Question: Author a descriptive caption for the visualization shown.
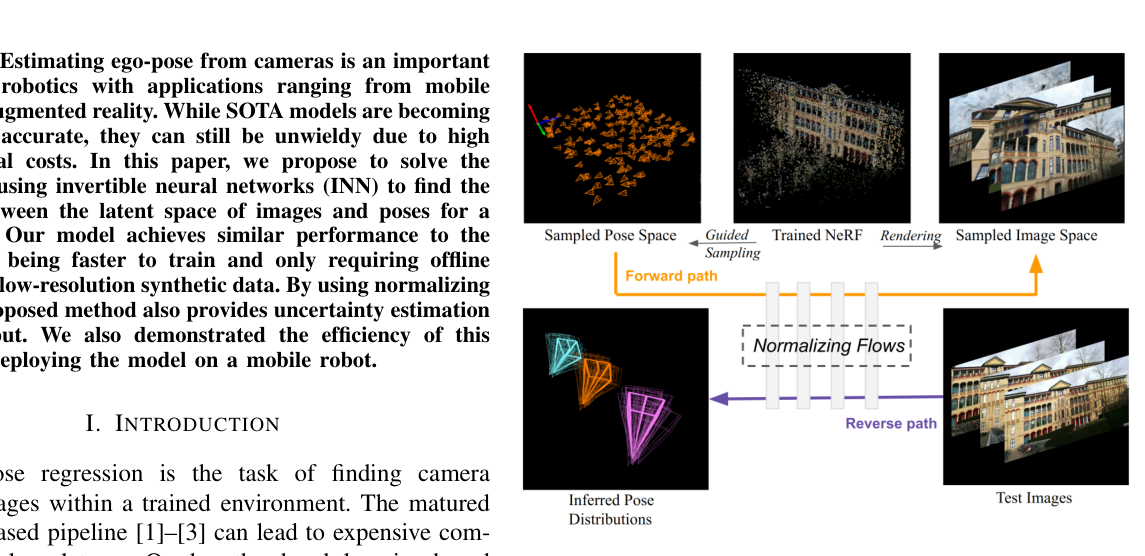
Answer: We propose to learn a mapping between the latent space of the images and camera poses in an environment with an invertible neural network. We use NeRF to guide camera pose sampling and render synthetic images. Evaluating the reverse path of the INN outputs the full posterior distribution of camera poses given a test image.